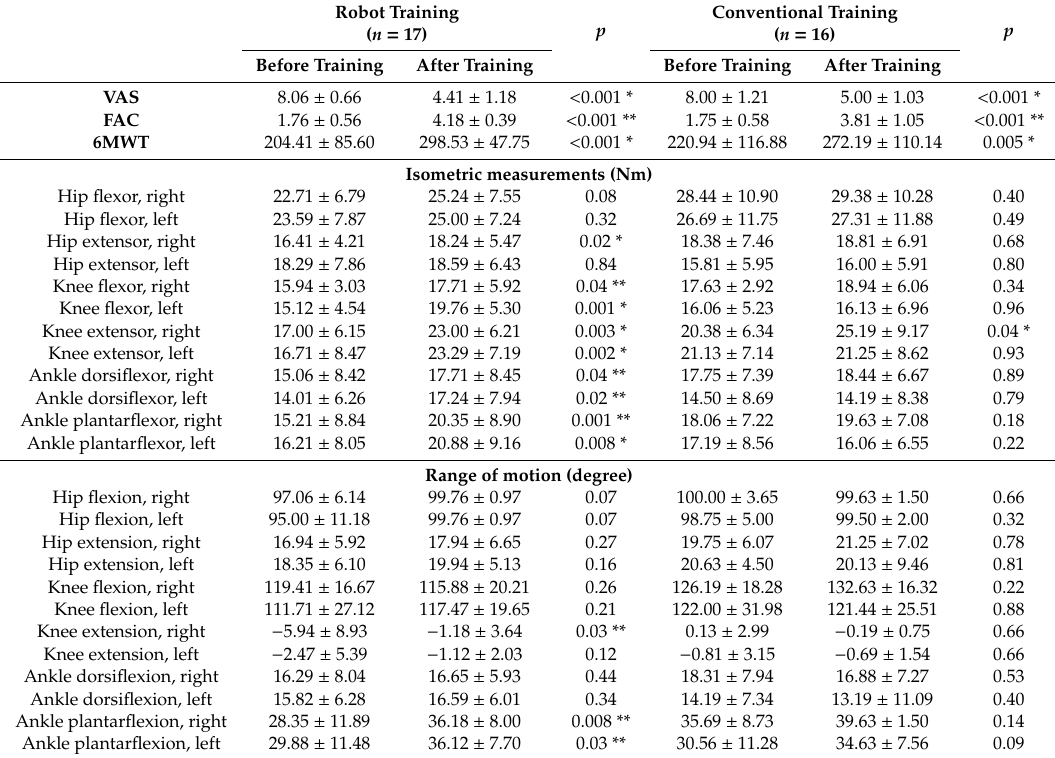
Table 2. Comparison between the scores before training and after training.